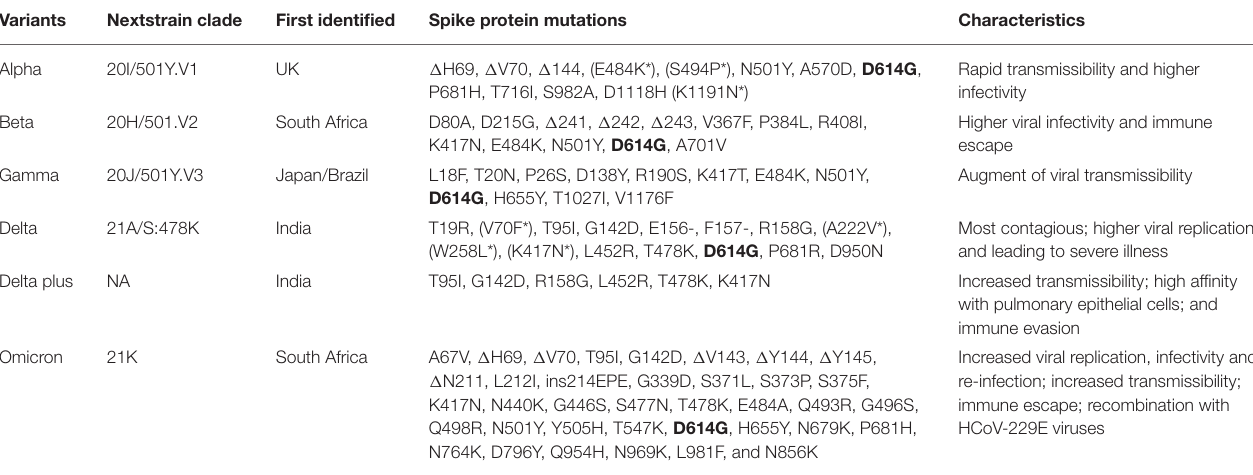
TABLE 1 | The characteristics of main variants of SARS-CoV-2 viruses.